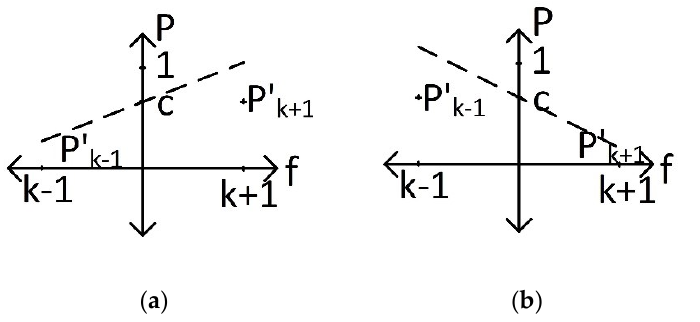
Figure 2. Regression lines around a peak with respect to beta: ( a ) case a: β < 0; ( b ) case b: β > 0.